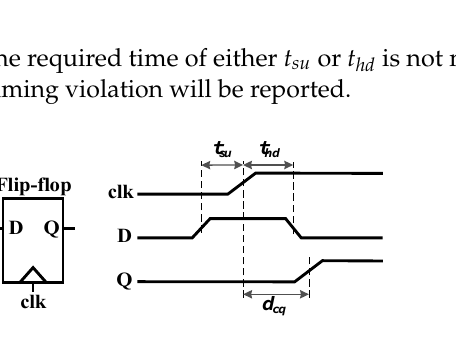
Figure 1. Setup time, hold time, and clock-to-q delay of a flip-flop. Figure 1. S etup time, hold time, and clock ‐ to ‐ q delay of a flip ‐ flop. Figure 1. S etup time, hold time, and clock ‐ to ‐ q delay of a flip ‐ flop.